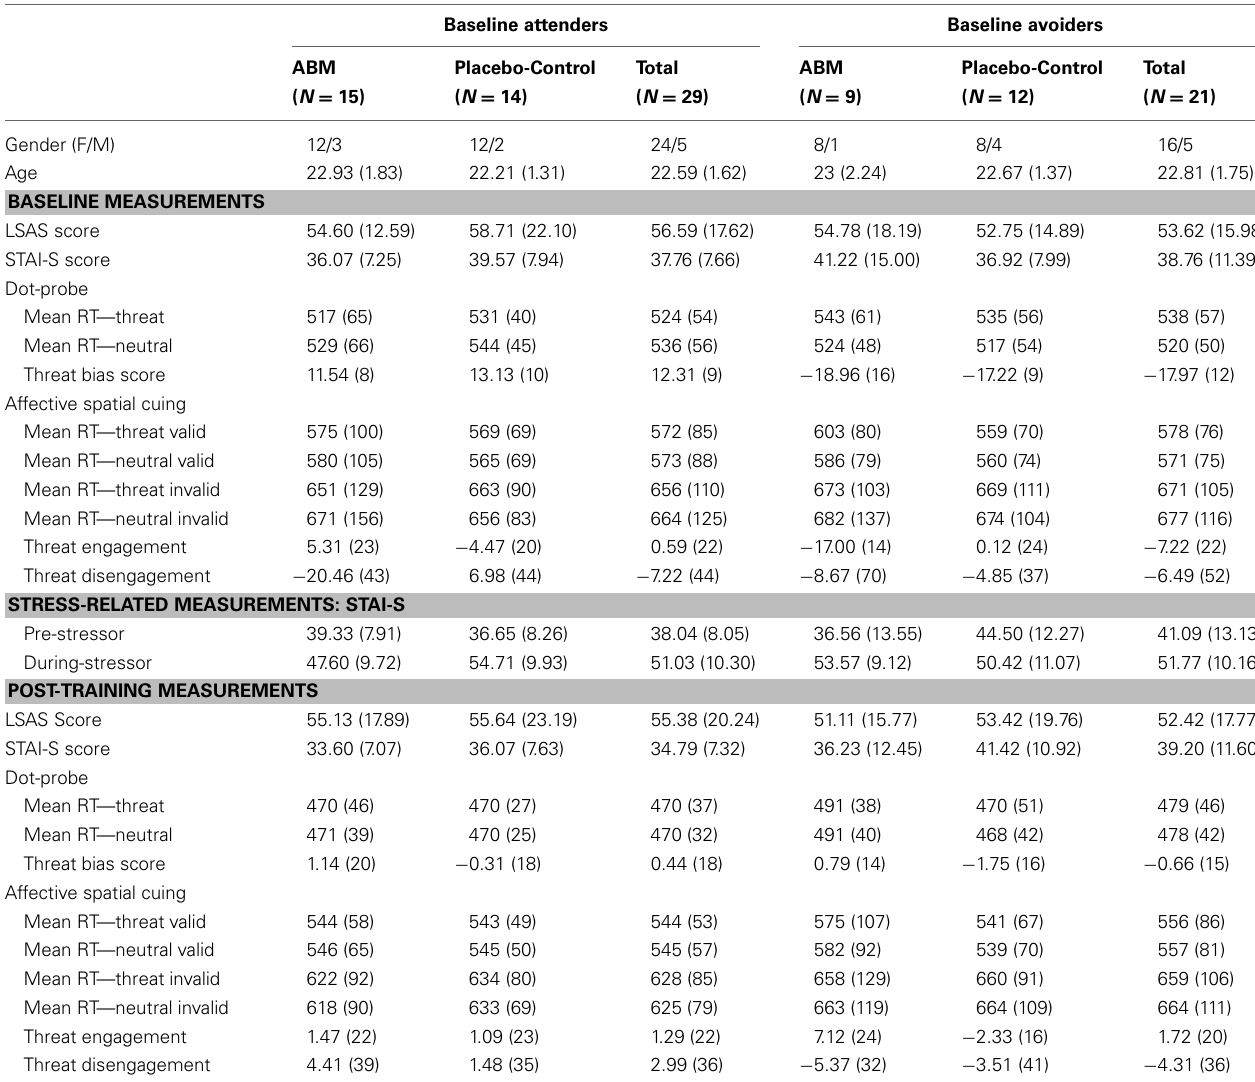
Table A1 | Means and SDs of baseline, post-training, pre-stressor, and during-stressor measurements for baseline attenders and avoiders by training